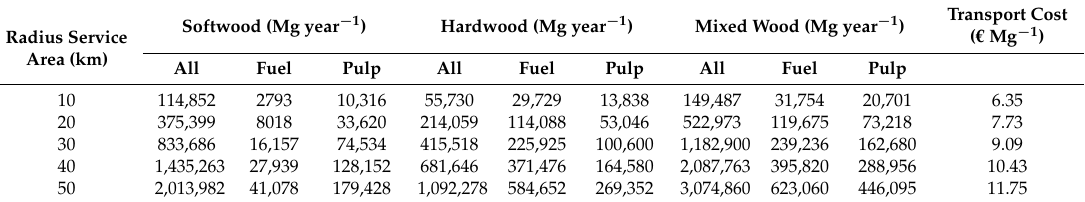
Table 6. Potential biomass from the positions with the highest annual